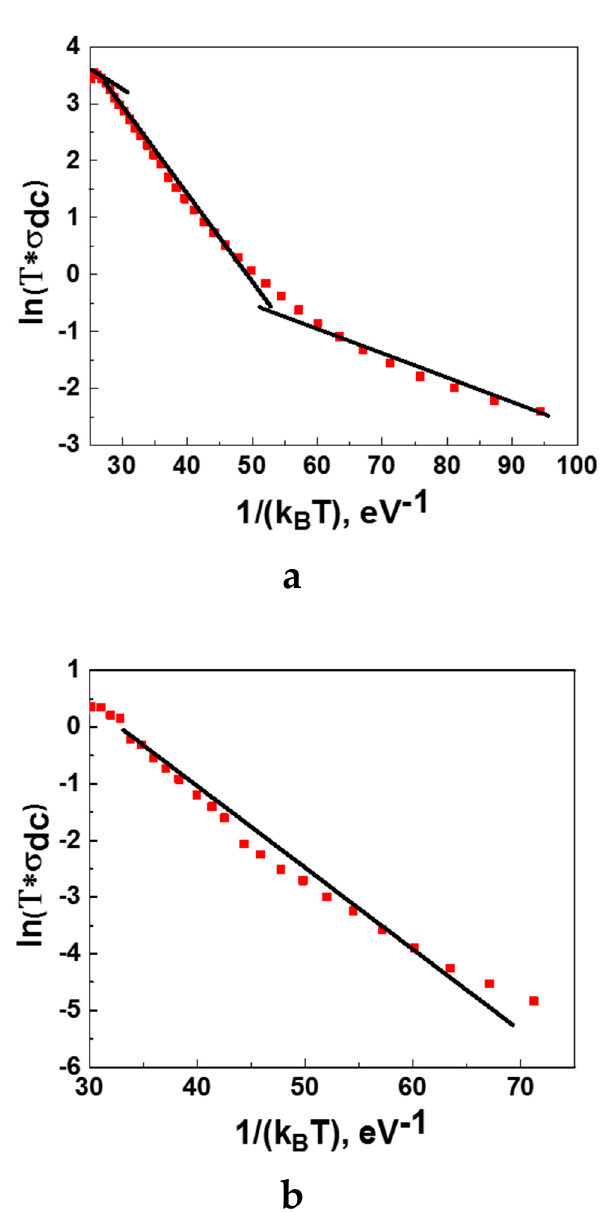
for La-CMFCNO ( a ) and Nd-CMFCNO ( b ). Figure 8. Dependence of ln( σ DCT ) on 1 k B T (cid:3038) (cid:3251) (cid:3021)